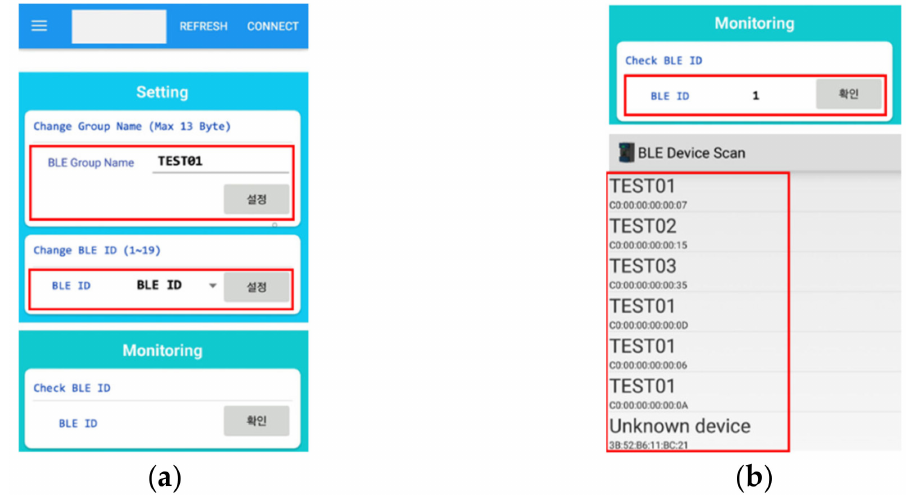
Figure 15. Setting and modification of peripheral processor group information through the app: ( a ) setting and modification; ( b ) verification of group name and BLE